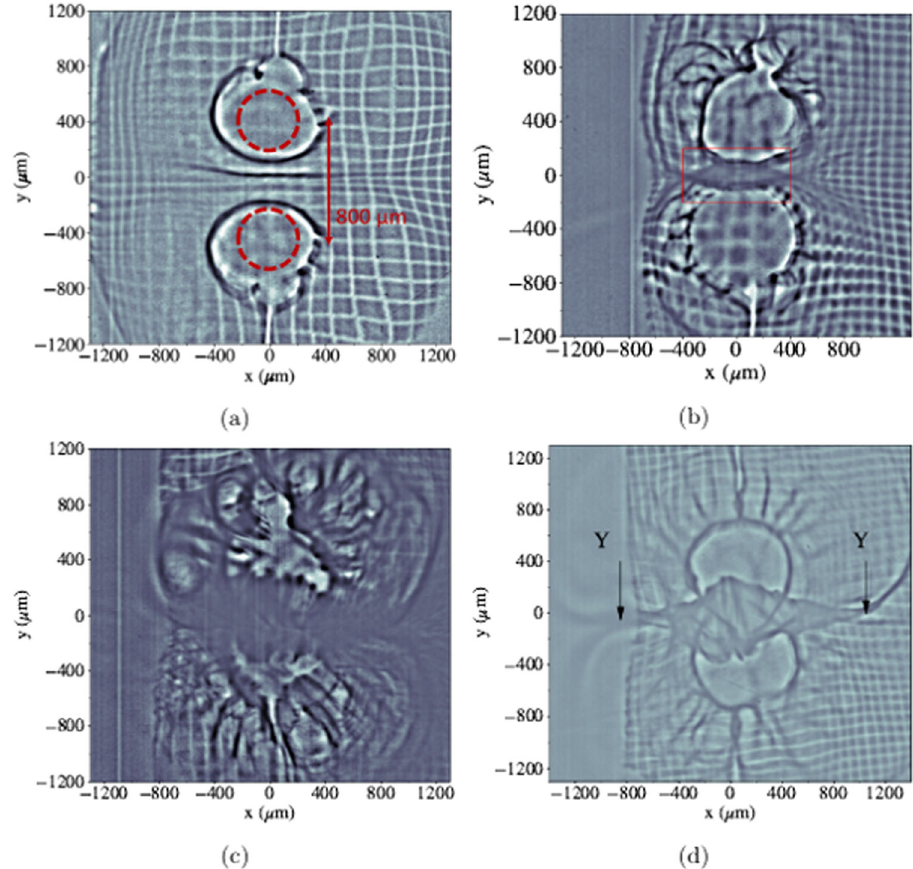
Fig. 2 Experimental proton radiographs at different probing times. The raw proton radiographs recorded at a t = 0.2 ns, b 0.5 ns, c t = 1.0 ns and ( d ) t = 1.5 ns. 17.4 MeV protons produce the radiographs shown in ( a ), ( c ) and ( d ) and 15.6 MeV protons produce ( b ). The image contrast has been adjusted to enhance the features in the radiographs. The red circles in ( a ) represent the approximate position of the original target discs. The points labelled ‘ Y ’ in ( d ) represent the region the bubbles start to separate away from each